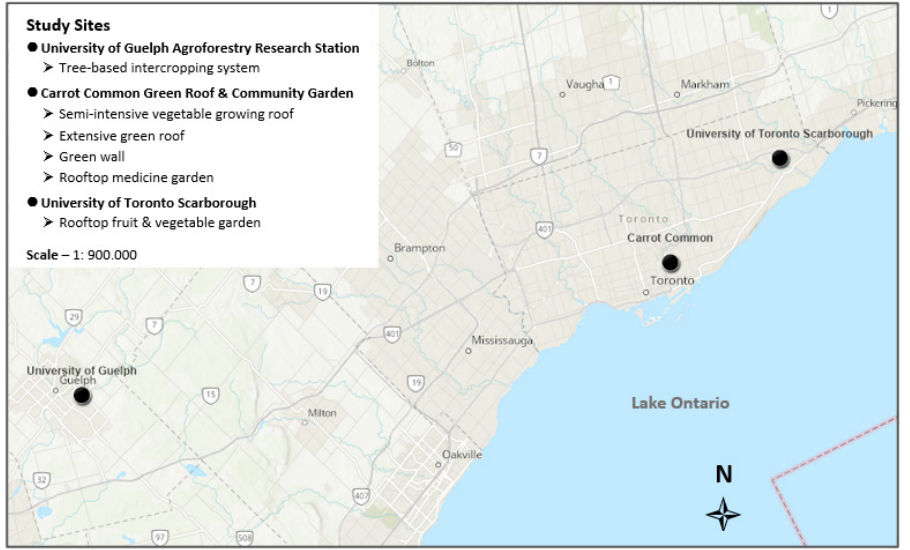
Figure 2. Map of field study sites.